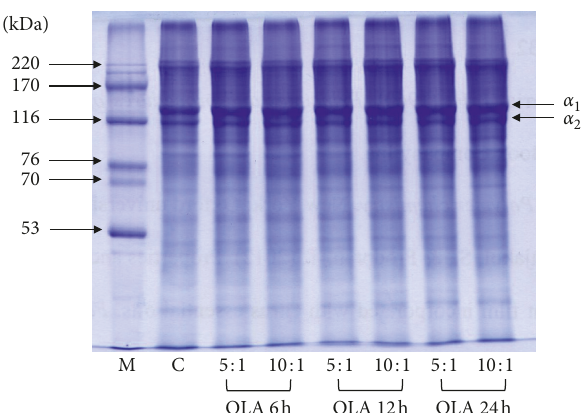
Figure 4: Protein patterns of fish gelatin modified with OLA prepared at different oxidation times and using various OLA-to- free amino group molar ratios. M: high MW protein marker and C: control gelatin (without